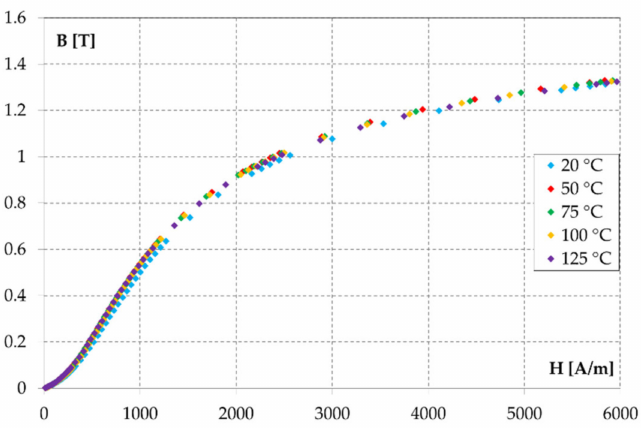
Figure 9. BH curves at different temperatures of SMC sample E